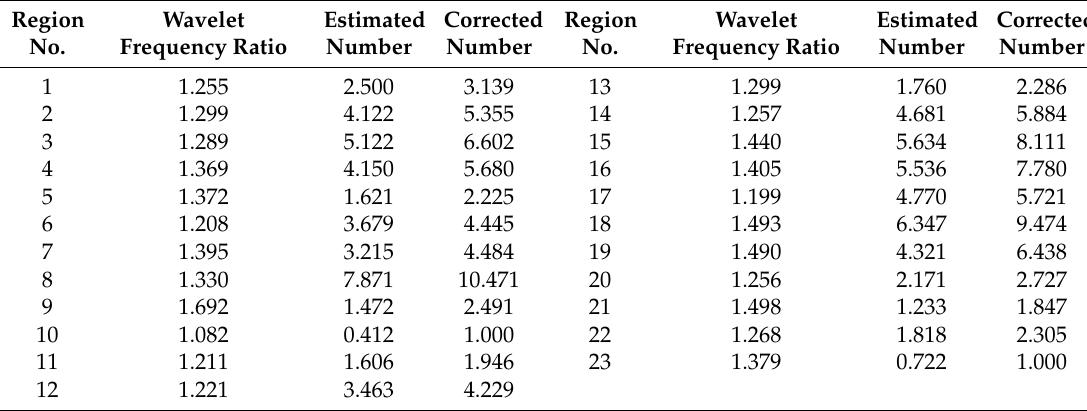
Table 2. Results for sample B